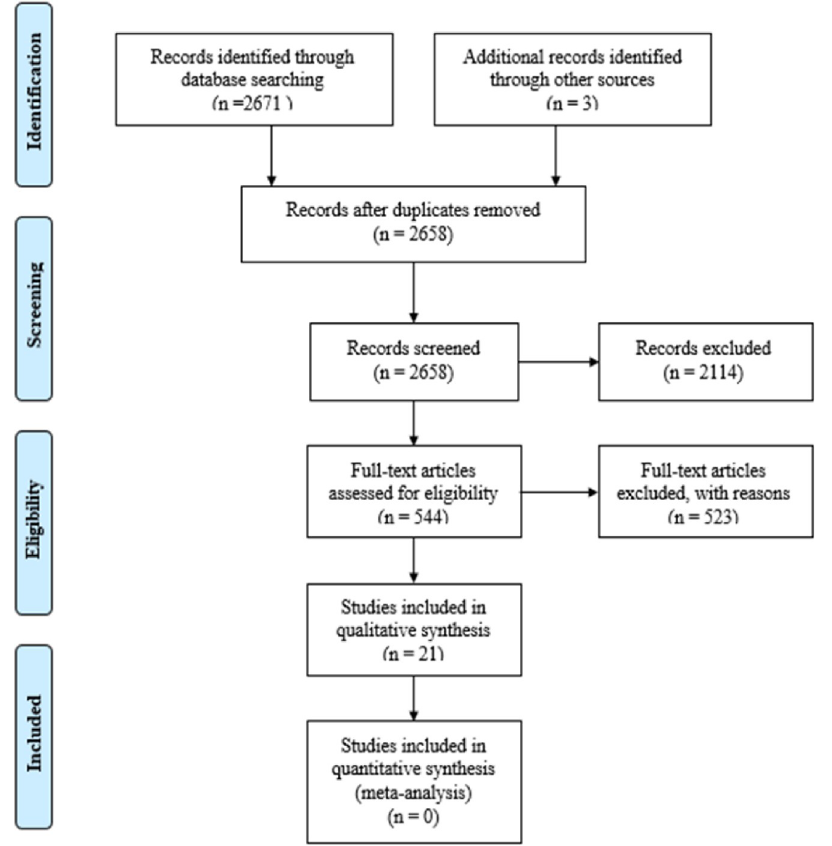
Fig 1. Flow chart study inclusion